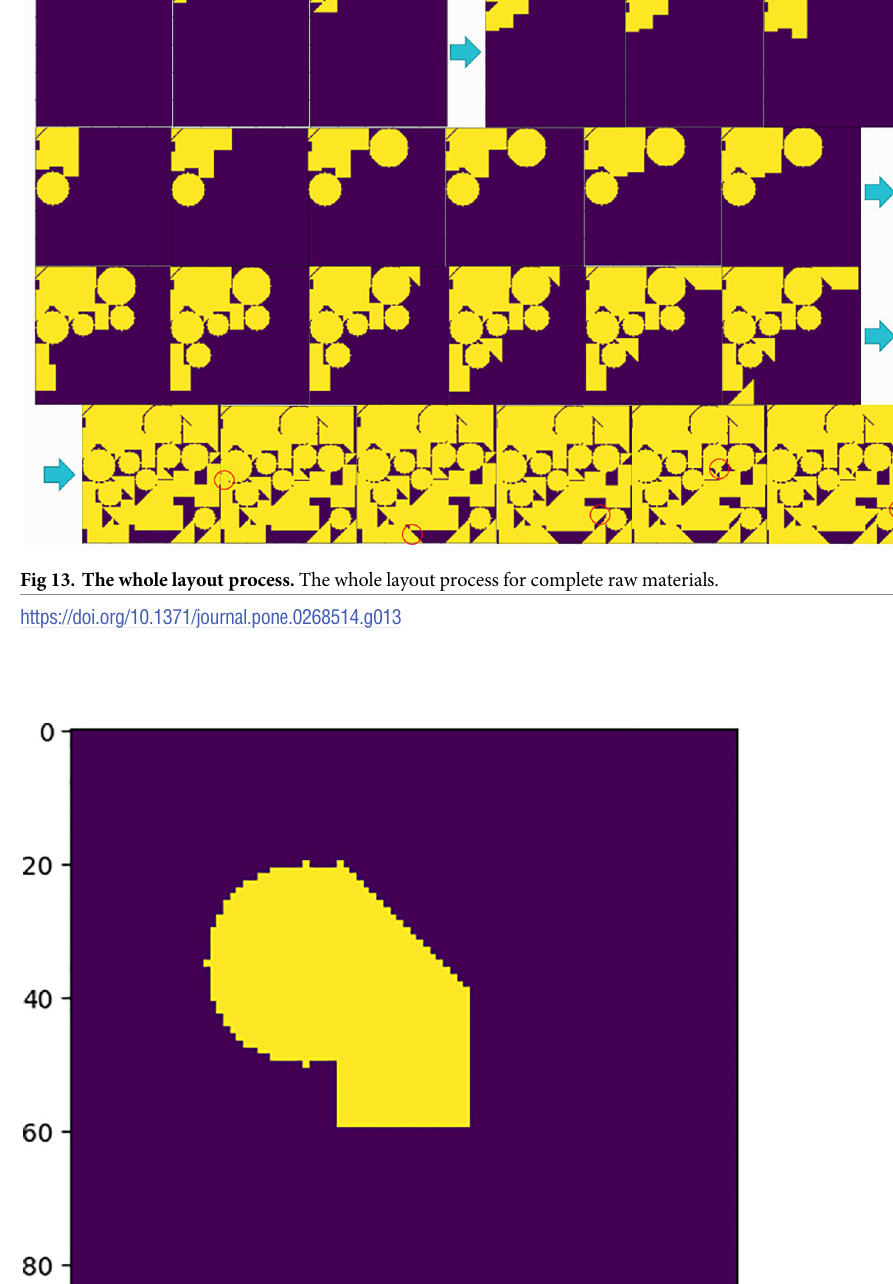
PLOS ONE | https://doi.org/10.1371/journal.pone.0268514 May 31,